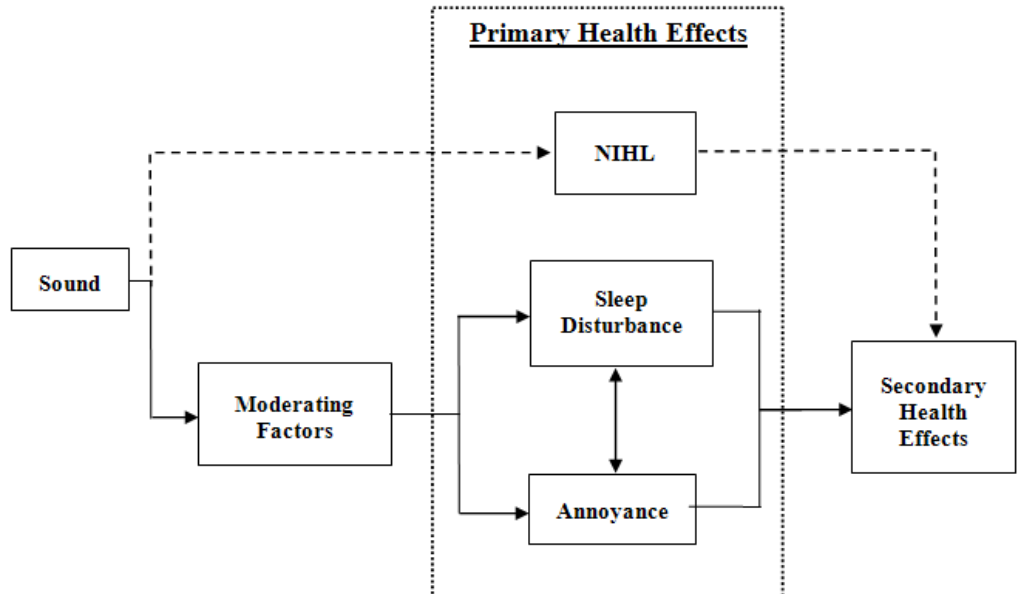
Figure 1. Model detailing how noise might compromise health. The dashed lines indicate the physical effects of noise, which include Noise Induced Hearing Loss (NIHL), while the solid lines represent the non-physical effects of noise. The box labeled “moderating factors” represents the cumulative effect of traits, contextual factors, and noise parameters (e.g., amplitude modulation). Annoyance and sleep disruption act as mediators between predisposing factors and secondary health effects (e.g., health-related quality of life or